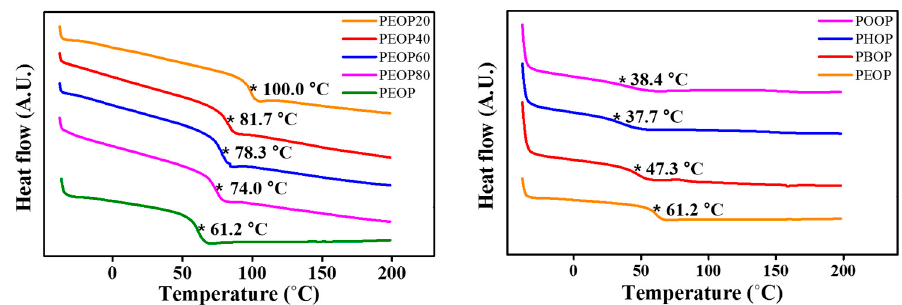
Figure 3. Differential scanning calorimetry (DSC) thermogram of PEOP# (PEOP20, PEOP40, PEOP60, and PEOP80) and PAOP (PEOP, PBOP, PHOP, and POOP). (* means the status of glass transition). Table 1. Reaction conditions and results for the synthesis of the PEOP# and PAOP (PEOP, PBOP, PHOP, and POOP). Polymer 小 Designation